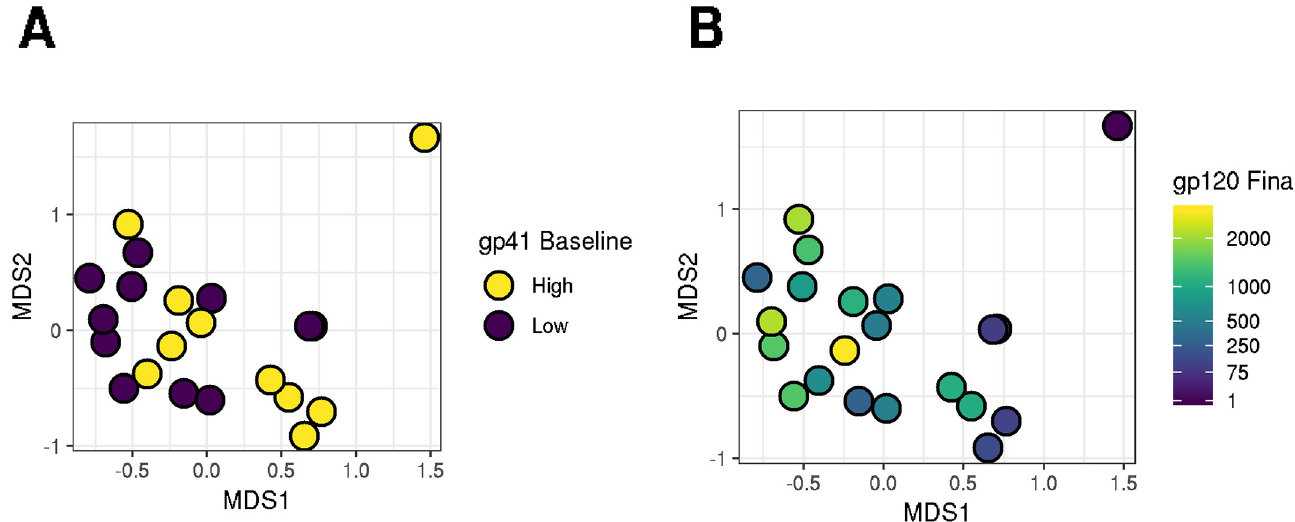
Fig 2. Dissimilarities between participants’ microbiota are related to dissimilarities in gp41 antibody magnitude at baseline, and gp120 magnitude at the final time-point. In this principal coordinates analysis, circles indicate participants. More distant circles indicate more dissimilar microbiota, as measured by weighted UniFrac. The first axis, MDS1 represents most of the variance, and later axes, MDS2 represents less variance. The first two axes are shown here and account for 29.1% and 17.2% of variance between participants. Positions of points in subplots are identical. Points in A are color coded by whether gp41 IgG concentration at day 0 is greater than or equal to (high—yellow) or lower than the median (low—blue). B is color coded by the Con 6 gp120 IgG concentration.